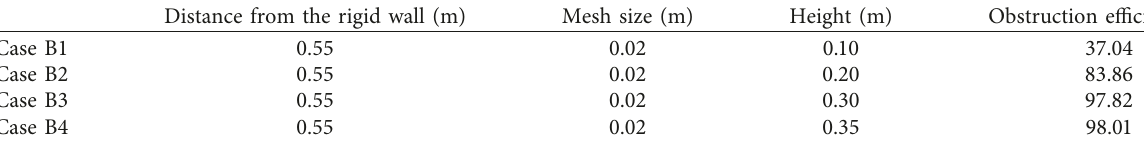
Table 3: Obstruction efficiency of RNB with different heights.